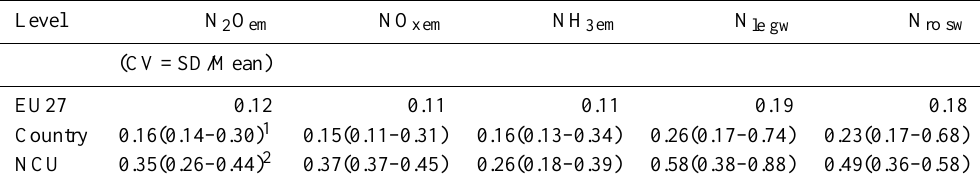
Table 7. Uncertainty (expressed as CV) for outputs at EU27 level, at country and NCU levels. Shown are the area-weighted average CV of N 2 O emission (N 2 O em ) , NO x emission (NO x em ) , NH 3 emission (NH 3 em ) , N leaching to groundwater (N le gw ) and N runoff to surface water (N ro sw ) for the EU27 for the year